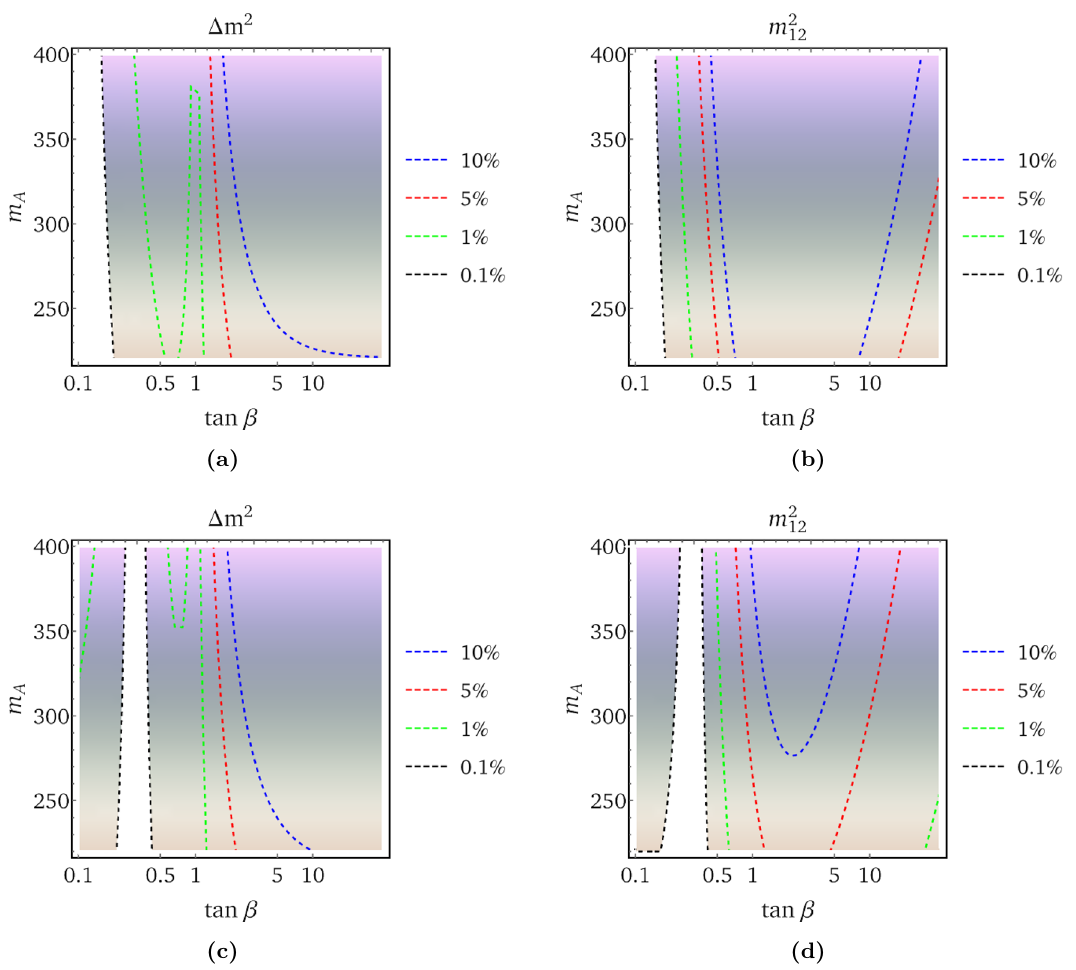
Figure 3. Contours of fine-tuning as defined in eq. (4.61). Panels (a) and (b) employ the benchmark points R = 0 and γ = 0 . 1 , whereas panels (c) and (d) employ the benchmark points R = 0 and γ = 0 . 3 . The shaded region inside and/or above each respective contour satisfies the corresponding tuning